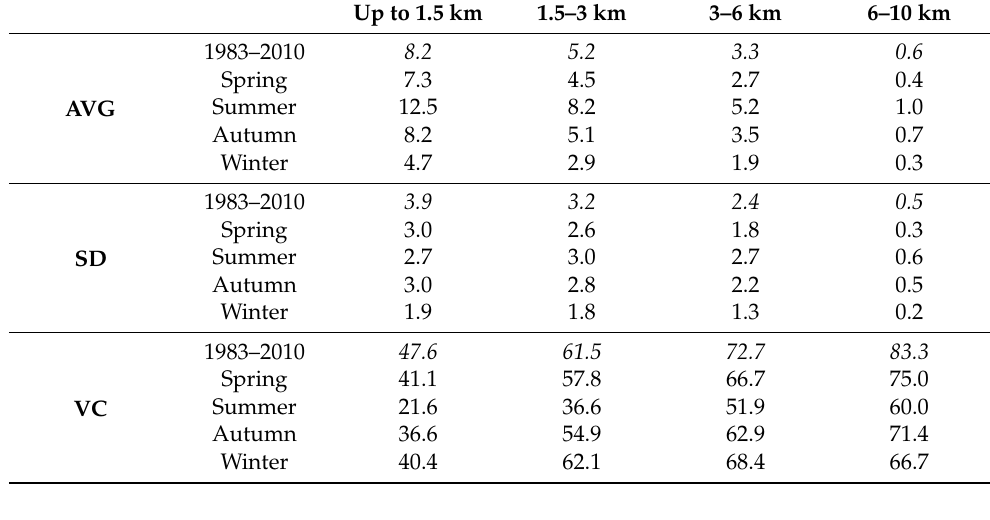
Table 6. Areal seasonal and multi-year means of PW–AVG (mm), standard deviation of PW–SD (mm) and variability coefficient of PW–VC (%) for individual tropospheric levels.